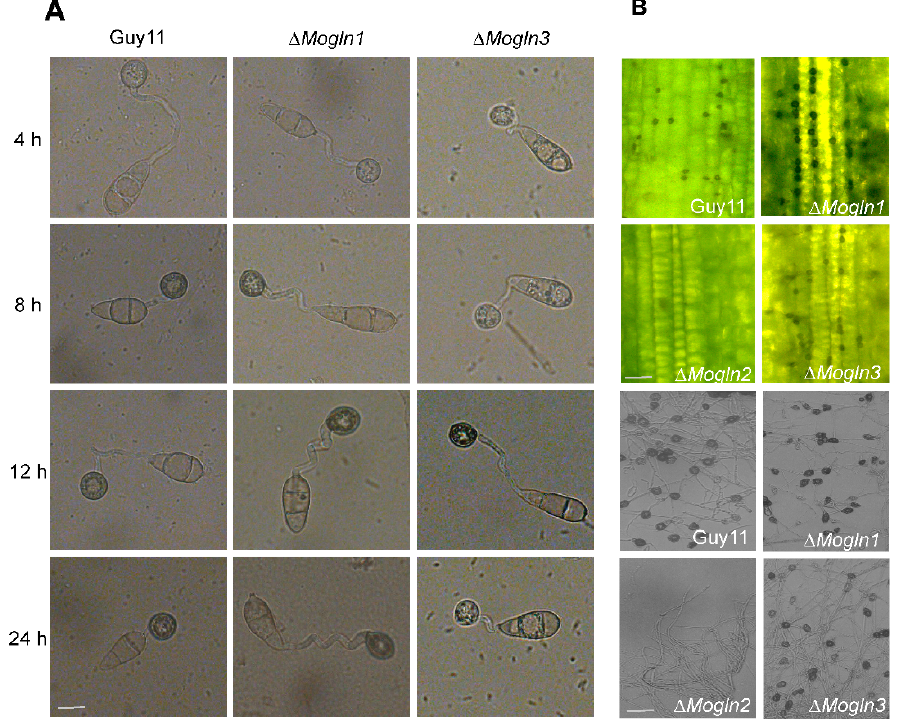
Figure 7. MoGln2 plays a crucial role in appressorium formation in rice blast fungus. ( A ) Bright field micrographs of the appressoria formed by WT, Δ Mogln1 , and Δ Mogln3 mutants on inductive hydrophobic cover slips. Conidia from WT, Δ Mogln1 , and Δ Mogln3 mutants were inoculated on a hydrophobic cover slip, and appressoria formation was observed at 4 h, 8 h, 12 h, and 24 h time intervals. Scale bar = 10 μ m. ( B ) An appressorium-like structure formed on a hydrophobic surface and barley leaves. Mycelia plugs derived from WT, Δ Mogln1 , Δ Mogln2, and Δ Mogln3 were inoculated on 10-day-old barley leaves, and inductive hydrophobic cover slips; appressorium-like structure formation was observed after 30 h. Scale bar = 10 μ m. The Δ Mogln2 mutant failed to form appressorium-like structures both on barley leaves and hydrophobic cover slips.